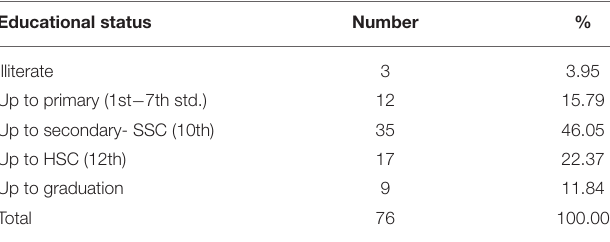
TABLE 3 | Educational status of the woman participating in FGD, Nashik, India,